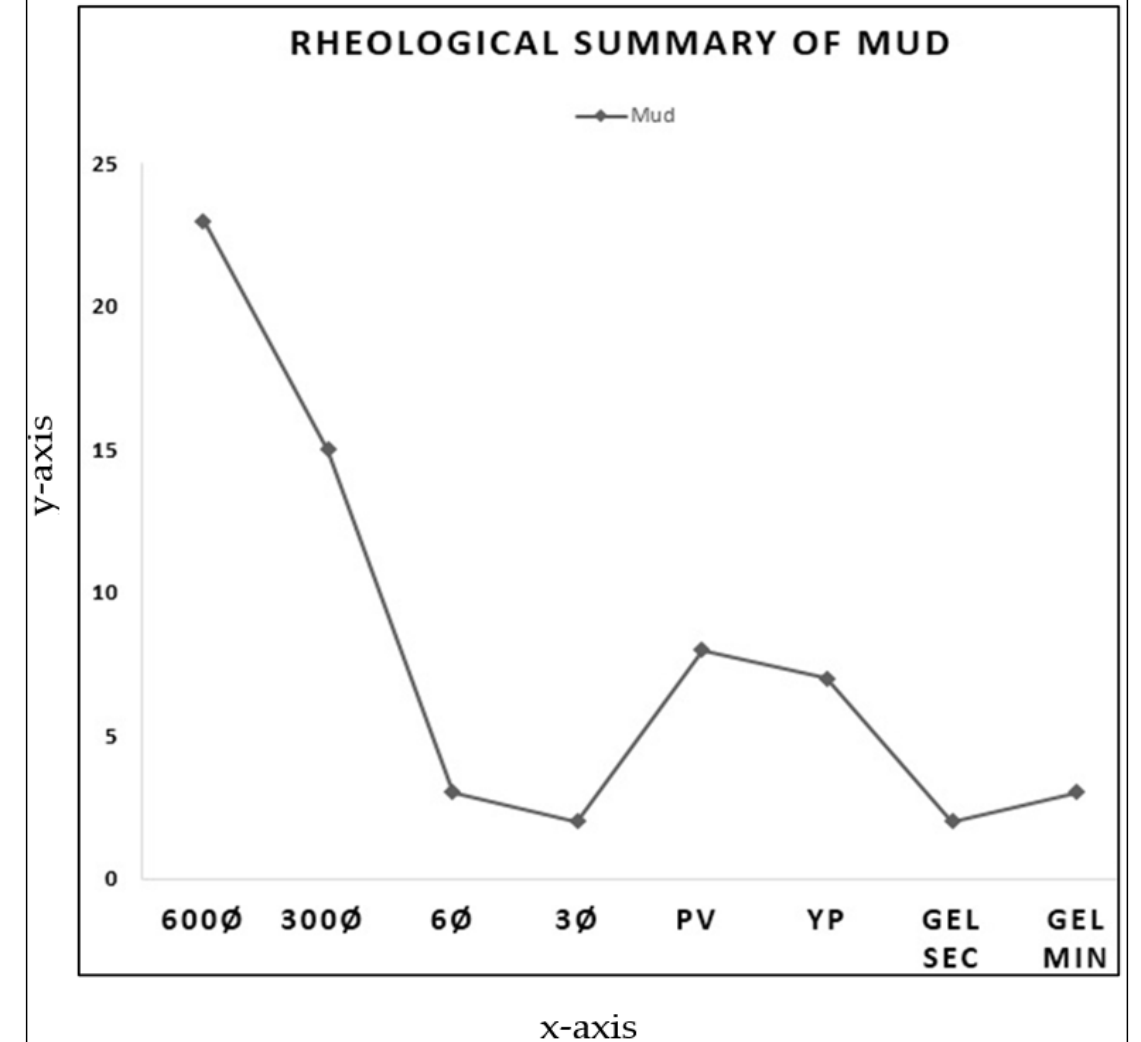
Figure 4. Trend of default rheological properties of mud. The x -axis indicates rheological properties, whereas the values on the y -axis are indicative of rheological values of the mud. Table 2. Rheological properties of formulated mud. MIXTURE